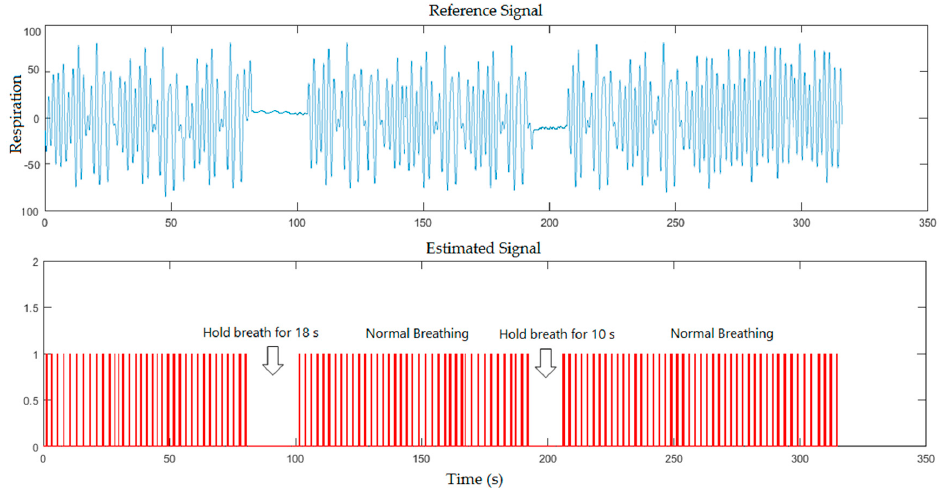
Figure 6. A five minutes simulation for healthy subject where the subject was asked to hold his breath twice during the measurement for the first scenario (with a blanket).